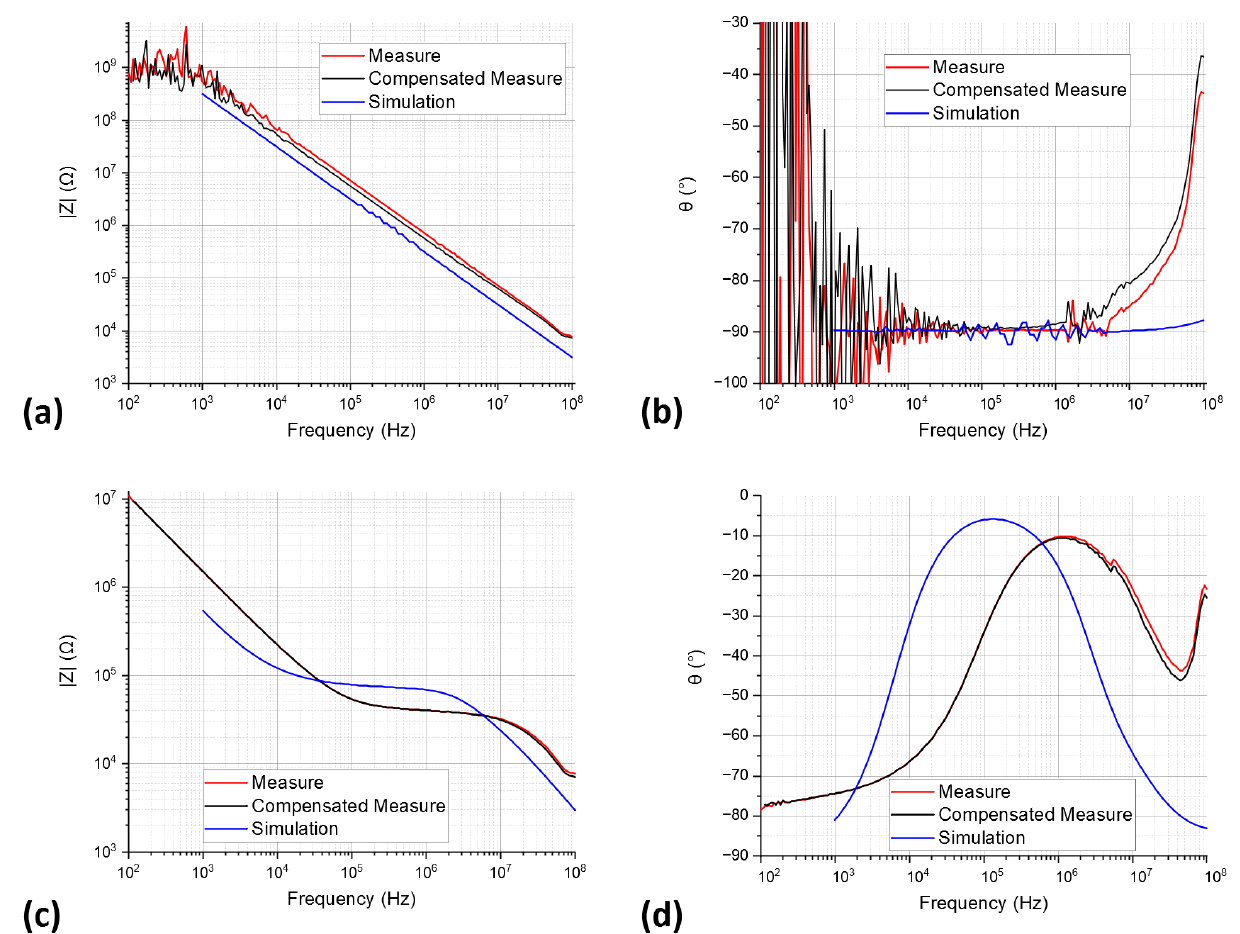
Figure 12. Comparison of the impedance modulus ( a ) and phase ( b ) of a microelectrode pair with a channel full or air measured (MEAS_AIR with and without compensation obtained with the Equation (1)) and simulated (SIM_AIR). ( c , d ) Comparison of the impedance modulus ( c ) and phase ( d ) of a microelectrode pair with a channel full of an ionic solution measured (MEAS_SOL with and without compensation obtained with the Equation (1)) and simulated (SIM_SOL).